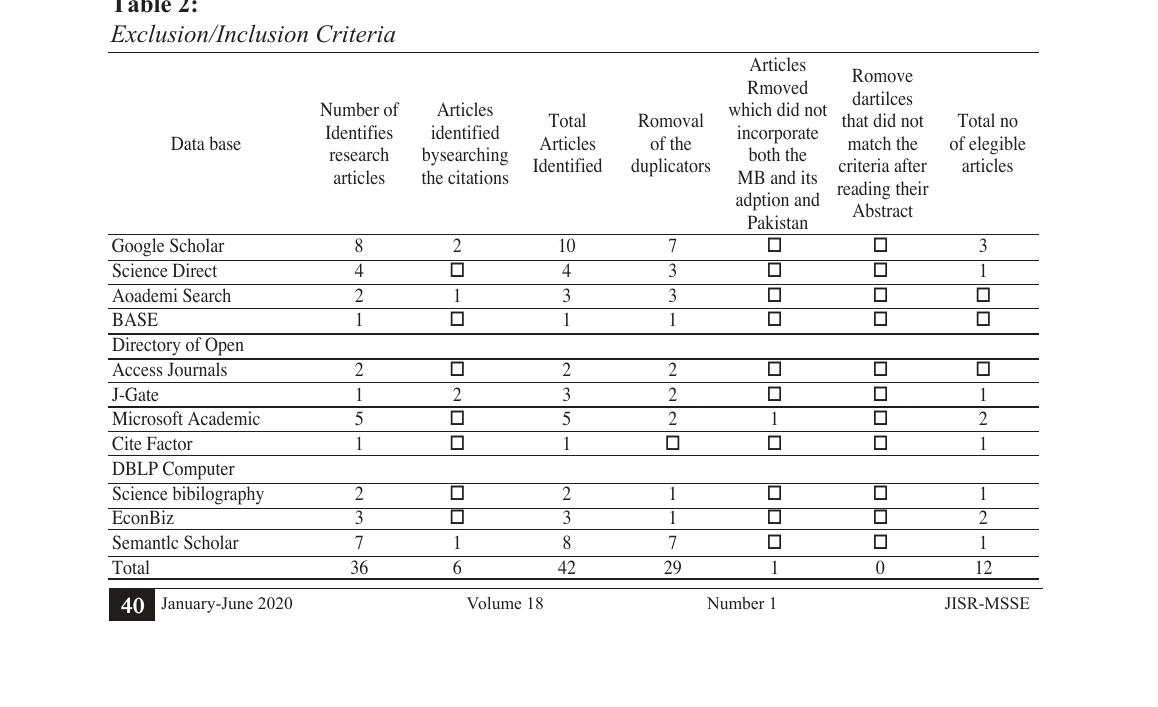
Total Articles Identified